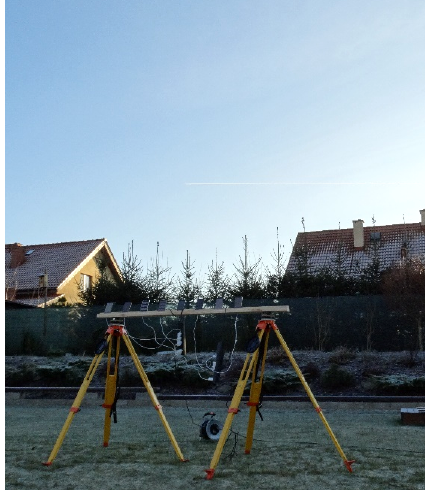
Figure 1. Smartphones during GNSS data collection.